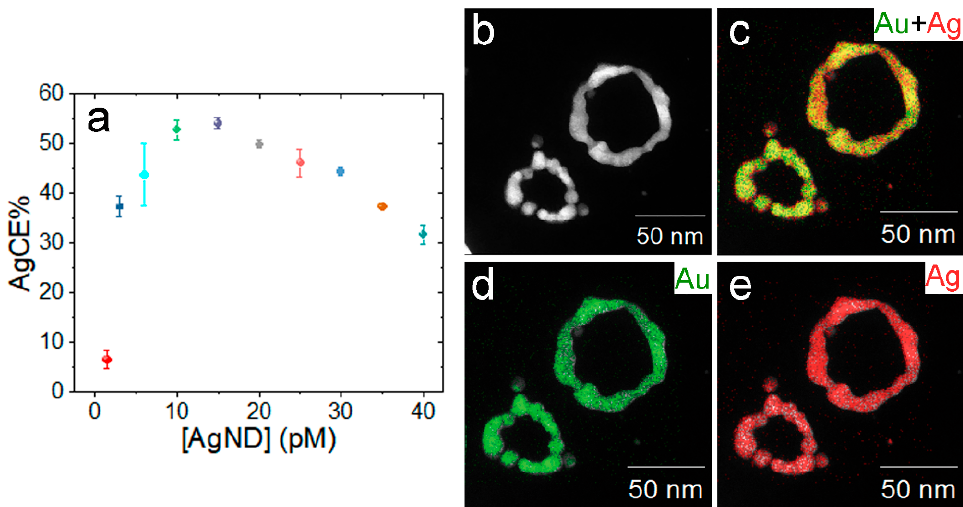
Figure 6. Confirmation of the GE mechanism for the MµB-AgNP MC assay. ( a ) AgCE% vs. the concentration of the AgNDs derived from the results shown in Figure 4. ( b ) Typical dark-field STEM image of the AgNDs following GE. As illustrated in Scheme 1, the AgNDs are converted to ring structures following GE. ( c – e ) EDS maps of ring structures shown in ( b ) for the elements indicated in the legends. Energy dispersive spectroscopy (EDS) was performed using a JEOL NEOARM TEM at an accelerating voltage of 80 kV with a point-to-point STEM resolution of 0.11 nm.